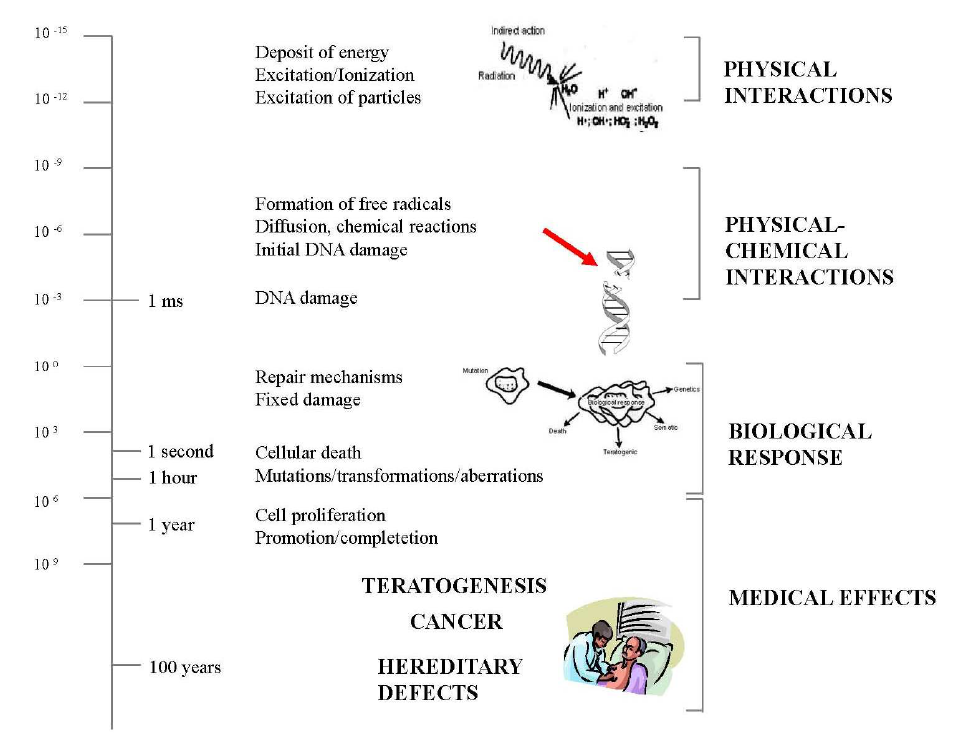
Figure 1. Chemical and biological effects by ionizing radiation. On the left side: from physical interaction (a few milliseconds) to clinical effects (decades later). On the right side: the corresponding molecular (DNA damage), cellular (cell damage or proliferation), and clinical events (such as cancer). Redrawn and modified from ref.